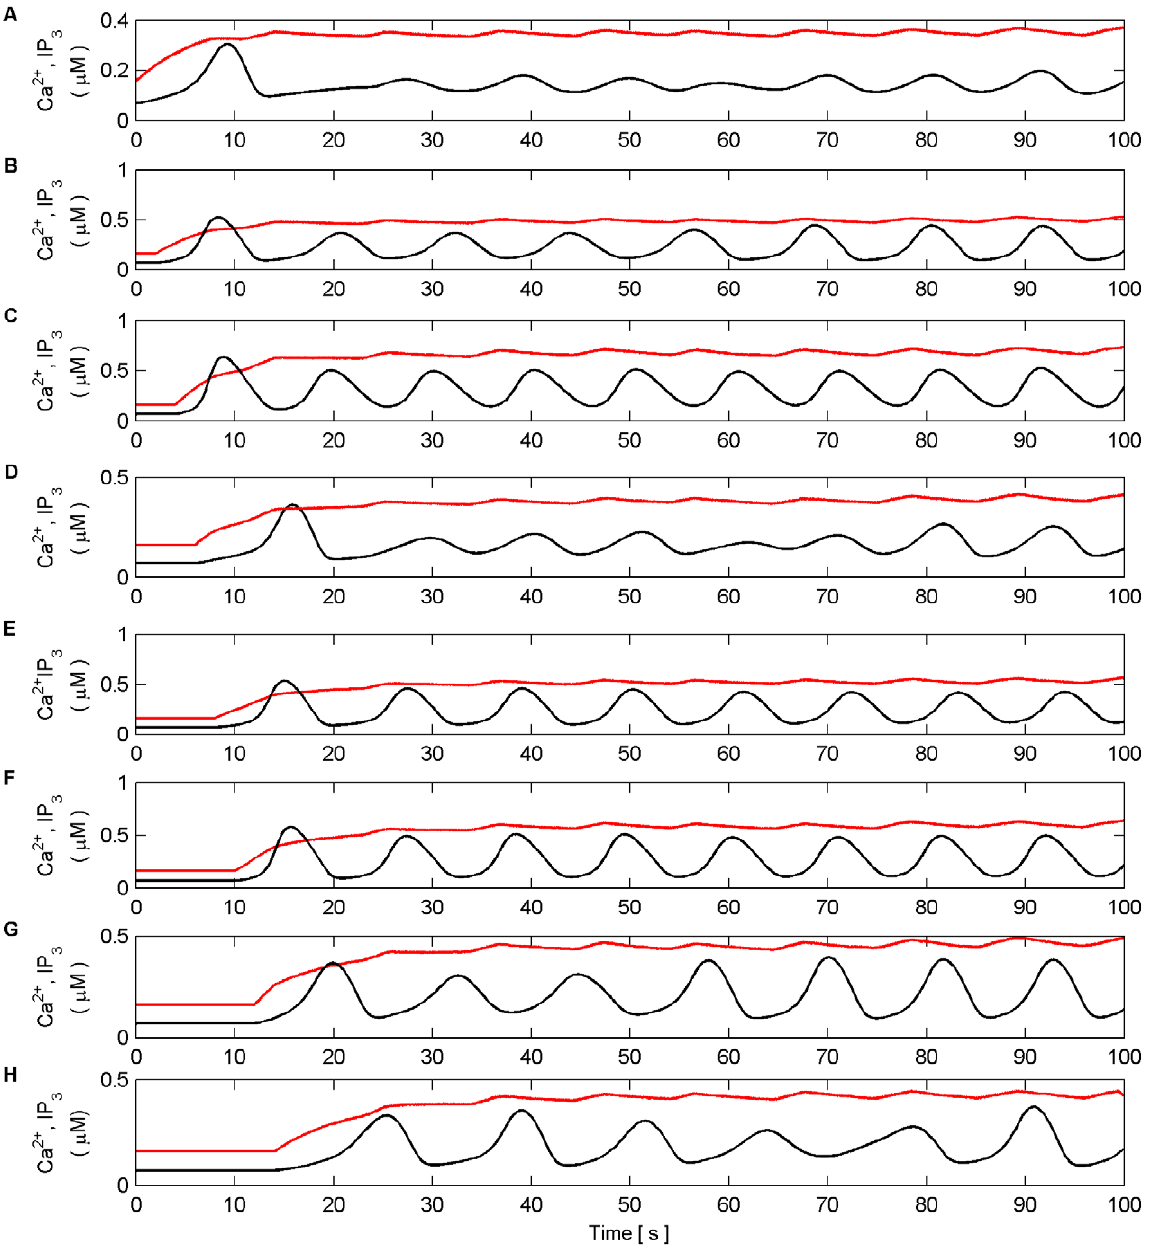
Figure 19. Individual Ca 2 + oscillations and IP 3 levels in AM mode. (A–H) Individual Ca 2 + oscillations (black), IP 3 transients (red) in each of the 8 microdomains associated with the synapses of N1 (A–D) and N2 (E–H). The input stimulus to each microdomain is a Poisson spike train with an average frequency of (A) 5 Hz (0 s–100 s), (B) 9 Hz (2 s–100 s), (C) 15 Hz (4 s–100 s), (D) 6 Hz (6 s–100 s), (E) 10 Hz (8 s–100 s), (F) 12 Hz (10 s–100 s), (G) 8 HZ (12 s–100 s), (H) 7 Hz (14 s–100 s). Note how the phase of the individual oscillations phase lock each microdomain Ca 2 + oscillation.